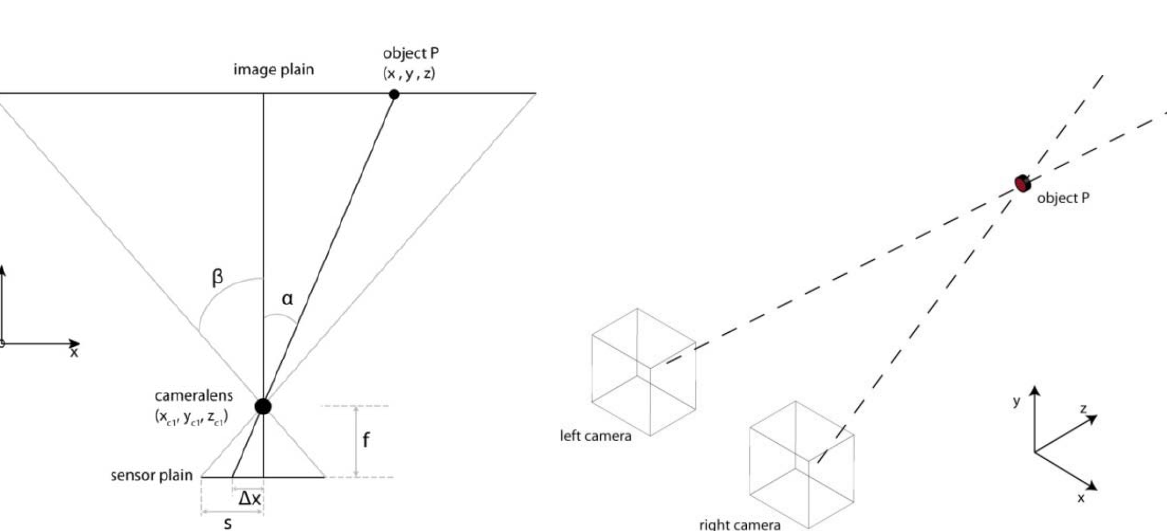
Figure 8. Left: Model and detail of camera (Left); Right: stereo